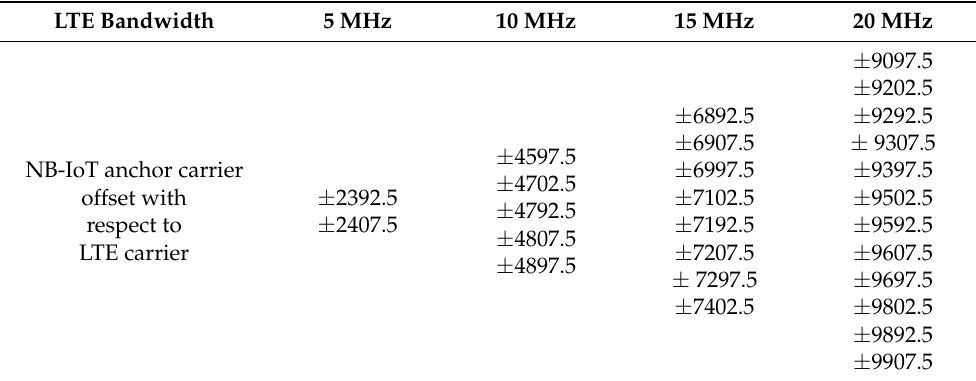
Table 1. Indices of available PRBs for NB-IoT in In-band mode [13,15,18,30]. Adapted from ref [13]. LTE 3 MHz 5 MHz 10 MHz 15 MHz 20 MHz Bandwidth 4, 9, 14, 19, 24, 29, 2, 7, 12, 17, 22, 34, 39, 44, 55, 60, 27, 32, 42, 47, 4, 9, 14, 19, PRB indices 2, 12 2, 7, 17, 22 65, 70, 75, 80, 85, 52, 57, 62, 30, 35, 40, 45 90, 95 67, 72 Table 2. Available values of PRB frequency offsets with respect to the LTE carrier for NB-IoT Guard- Band mode [15,18,31,33]. Adapted from ref [33]. LTE Bandwidth 5 MHz 10 MHz 15 MHz 20 MHz